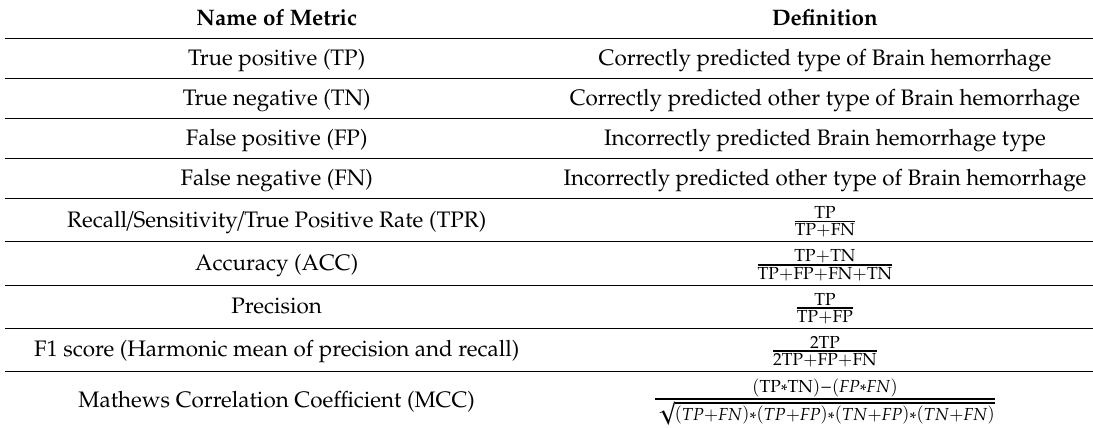
Table 1. Name and definition of the performance evaluation